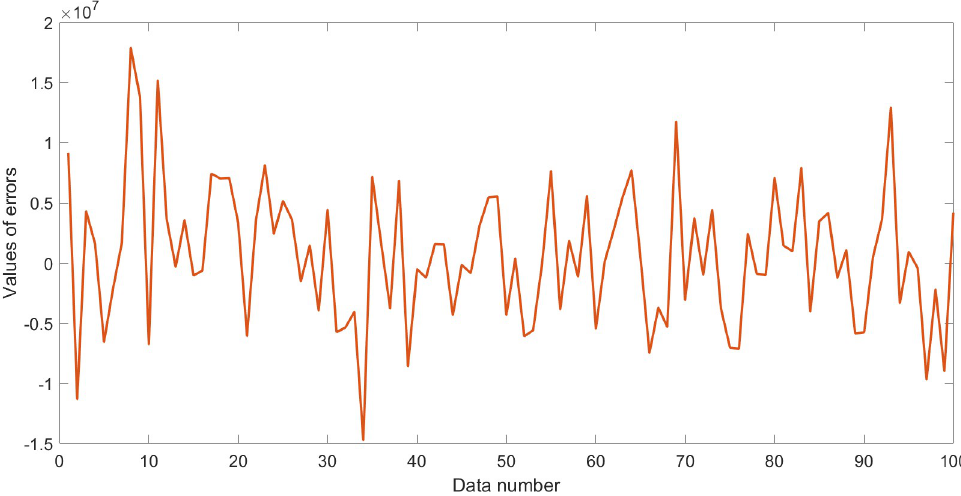
Fig 6. Values of errors in dataset